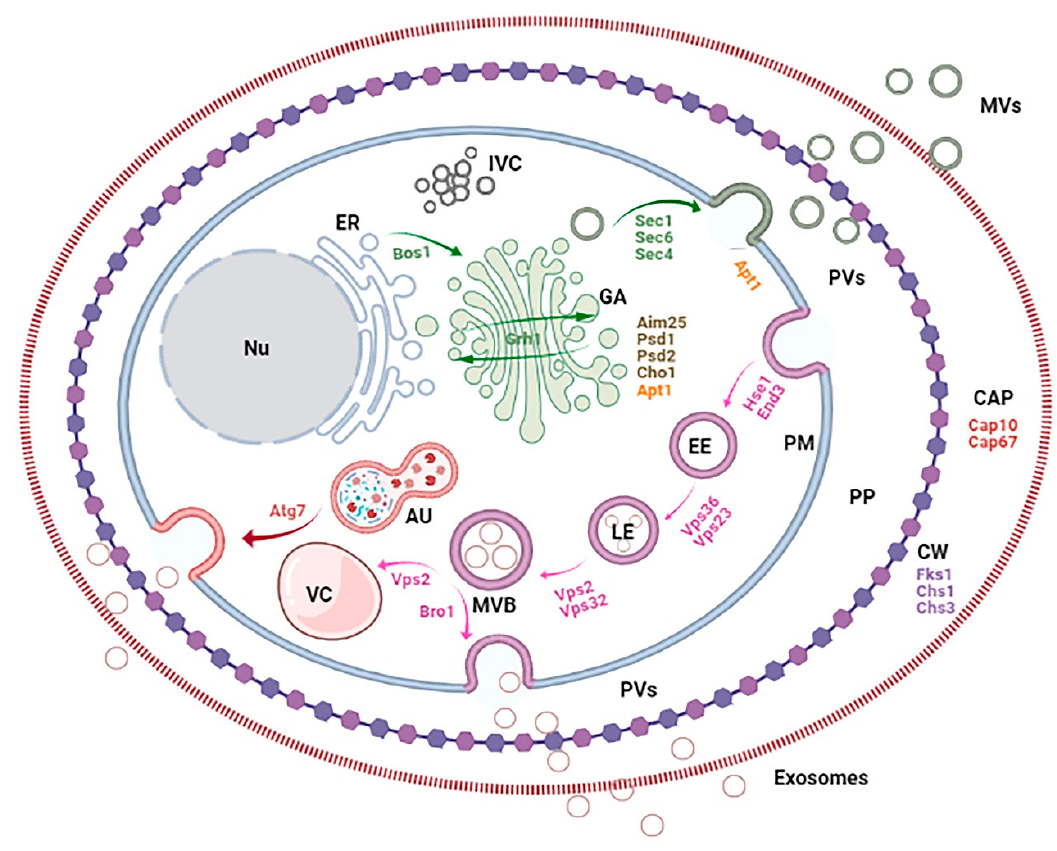
Figure 2. Fungal cell compartments, pathways and genes involved in EV biogenesis. The figure shows the conventional secretory axis (ER: endoplasmic reticulum; GA: Golgi apparatus; IVC: Intracellular vesicle clusters) and endocytic secretory pathway (EE: early endosomes; LE: late endosomes; MVB: multivesicular bodies; VC: vacuole), autophagosome (AU), cell barriers (PM: plasma membrane; PP: periplasm; CW: cell wall; CAP: capsule), vesicles (PVs: periplasmic vesicles and EVs, including MVs: microvesicles and exosomes) and nucleus (Nu).